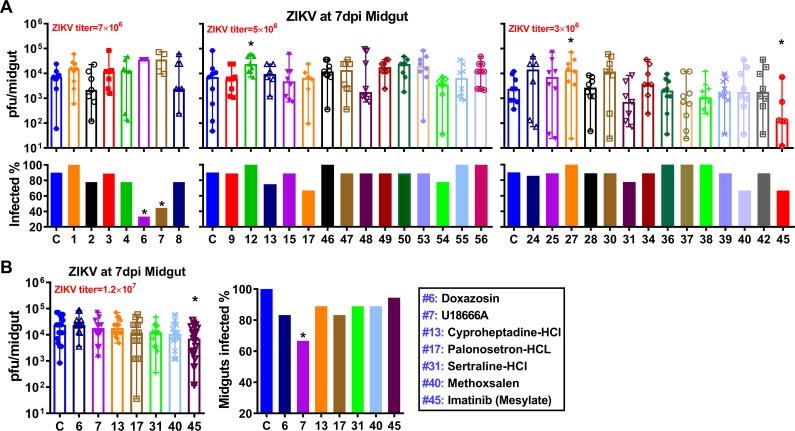
Anti-ZIKV activity of the rest of the anti-flaviviral drugs in Ae. aegypti.A and B, ZIKV titers and infection prevalence of individual midguts of females fed with each drug at 7 dpi, as determined by plaque assay in BHK cells. The final concentration of each drug in the ZIKV infectious blood meal was 100 μM, and the ZIKV titers in the blood meal are indicated in the figure. ZIKV were produced in C6/36 cells. Columns with error bars represent the median value with range of virus titer. P-values were calculated by a Mann-Whitney test for infection intensity or a Fisher's exact test for infection prevalence. *P<0.05, **P<0.01. One replicate for A, and at least two replicates for B.